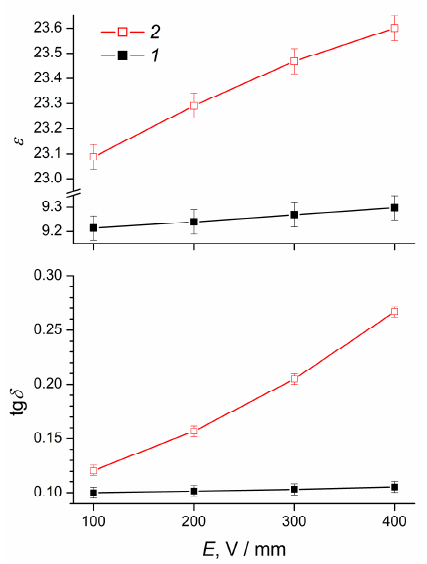
Figure 7. The dielectric constant ( ε ) and dielectric loss tangent (tg δ ) of composite elastomers (1) ERE-0 and (2) ERE-5 as functions of the electric field strength.